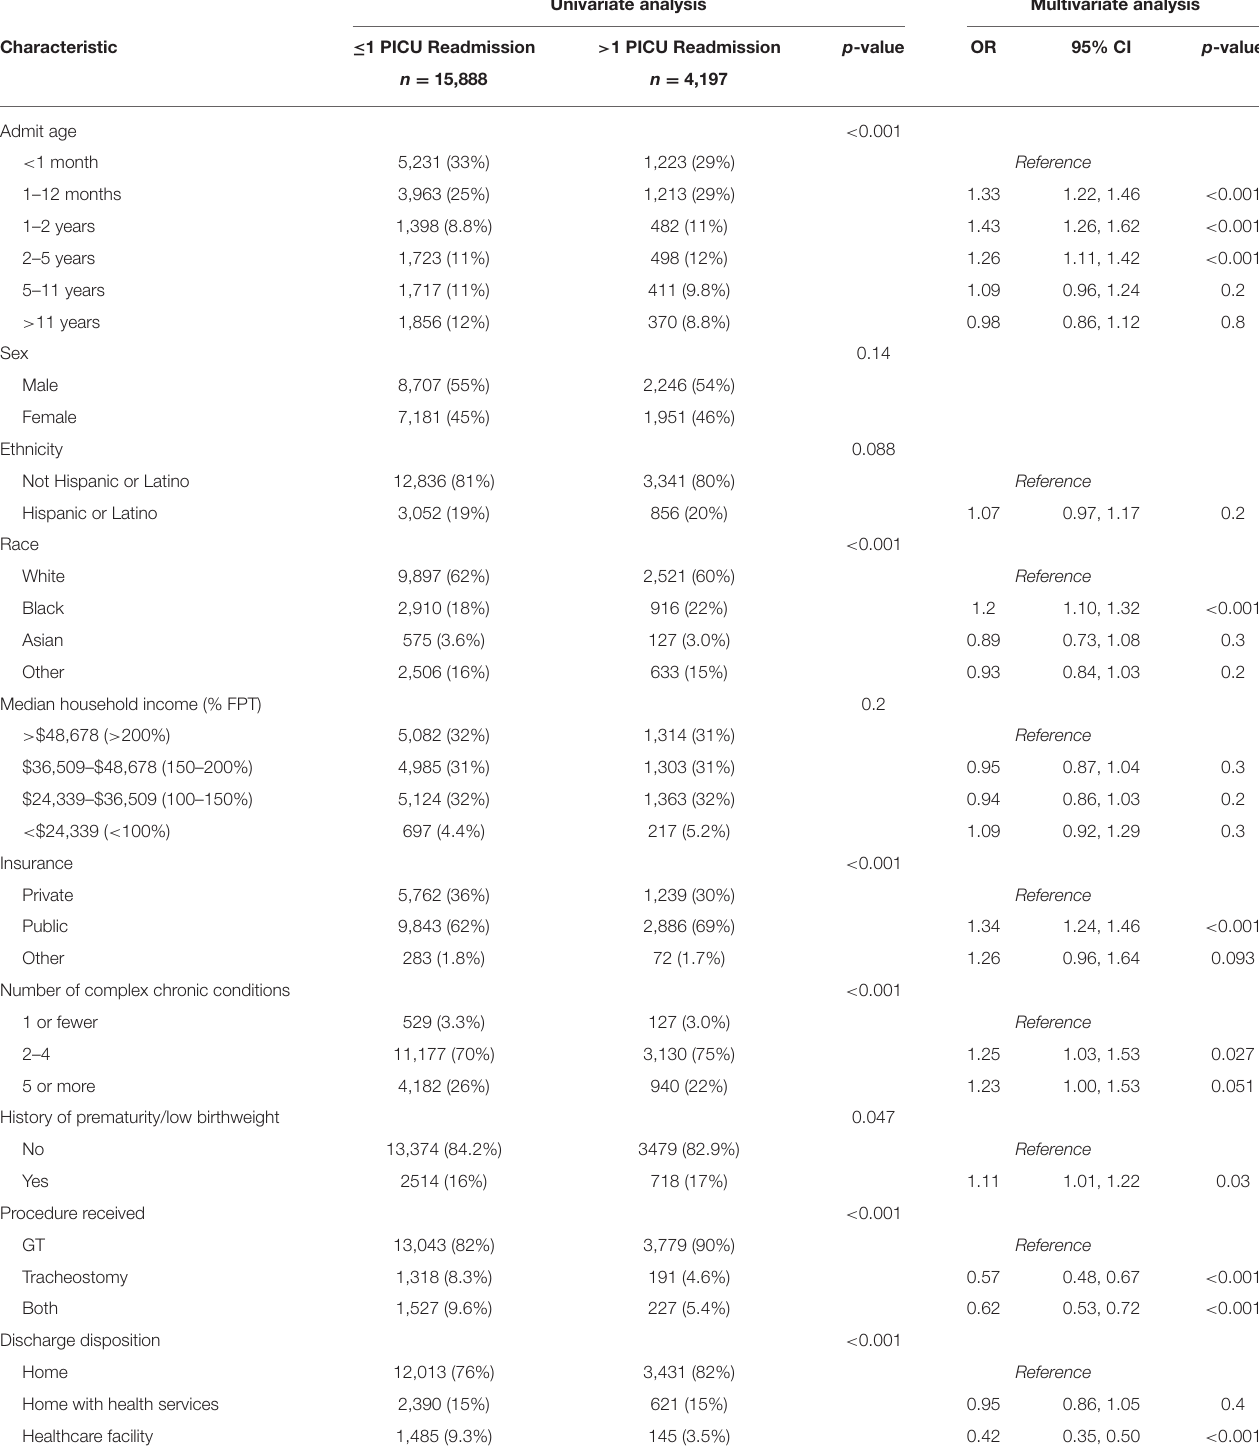
TABLE 3 | Univariate and multivariate analysis of characteristics associated with > 1 365-day PICU readmission in a cohort of technology-dependent children. Univariate analysis Multivariate